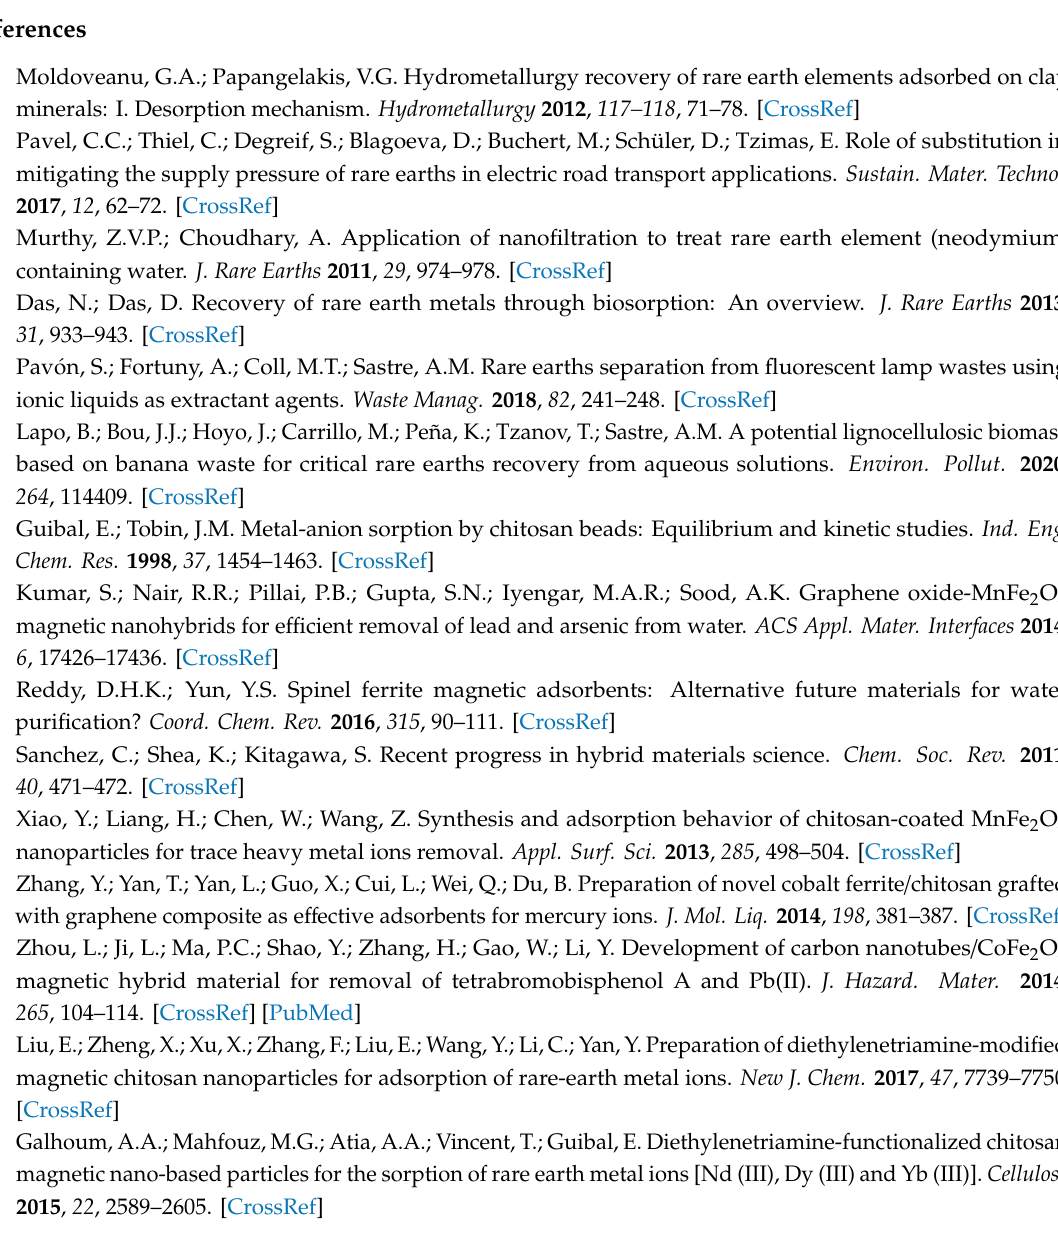
Figure S1: Diagram of chemical species of Nd 3 + , Figure S2: Intraparticle di ff usion coe ffi cients using CS-MF as